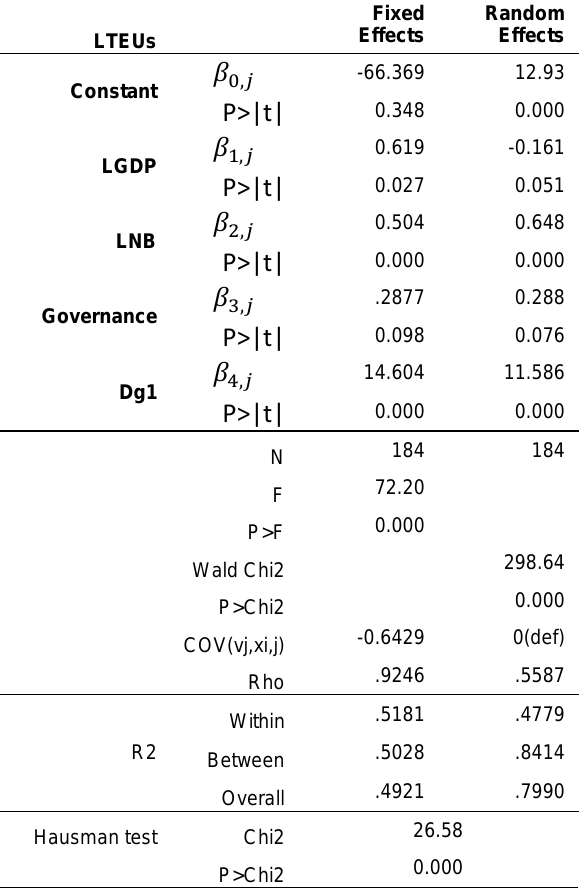
Table 1. Fixed Effects and Random Effects Model. Dependent variable: